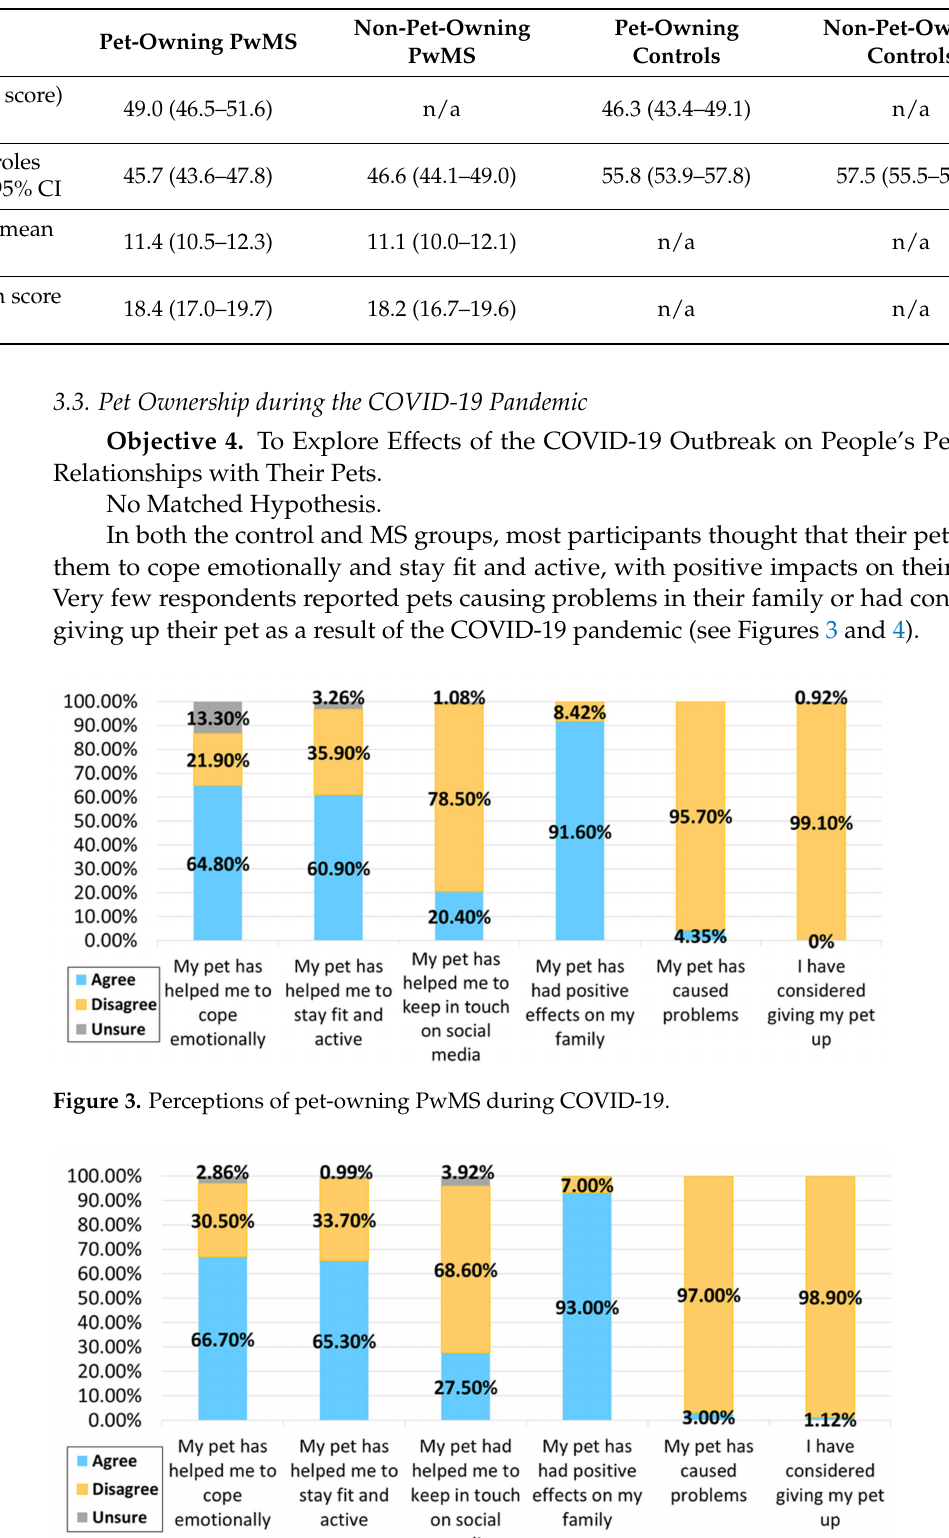
Table 4. Summary table of questionnaire results within participant groups.